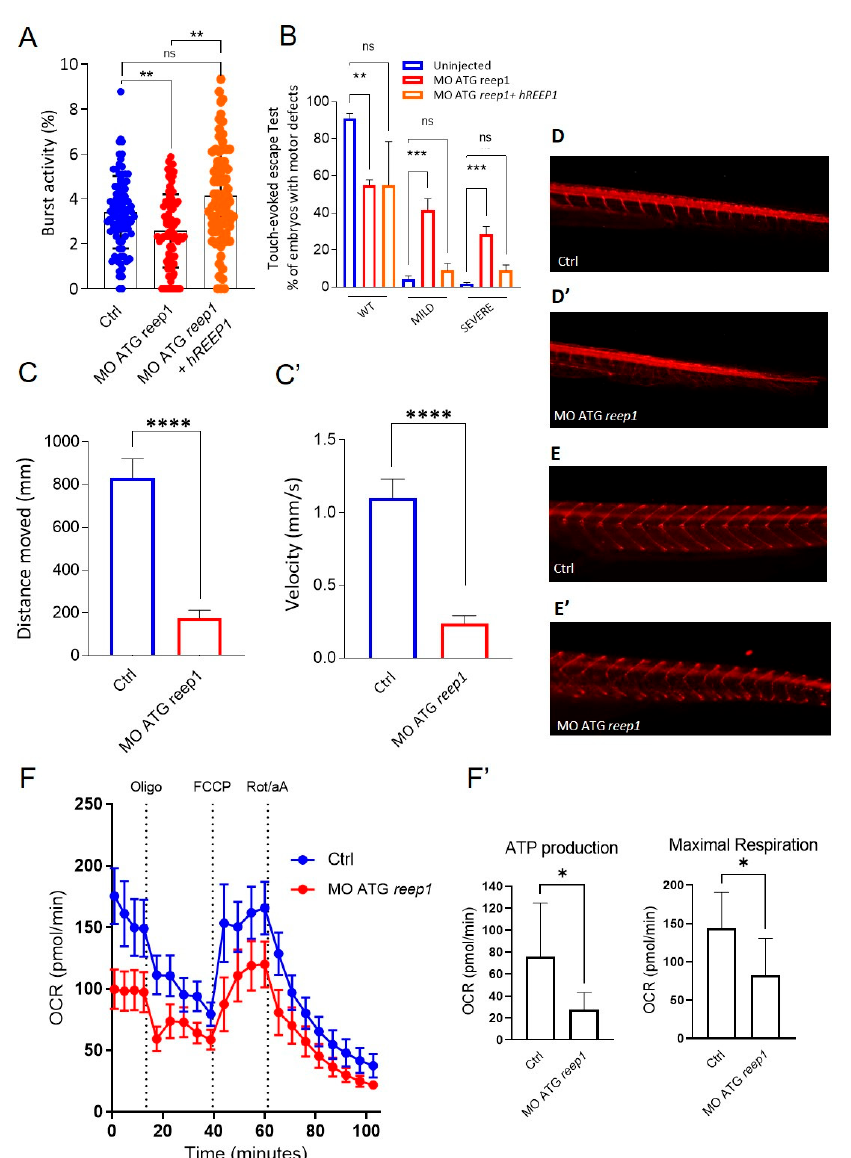
Figure 5. Phenotype characterization of the reep1 zebrafish model. ( A ) Coiling frequency in zebrafish embryos at 30 hpf is decreased in reep1 morphant compared with WT (MO ATG reep1 n = 90; controls n = 90; MO ATG reep1 + h REEP1 n = 90, in 3 independent experiments). The co-injection of embryos at one-cell stage with human mRNA/REEP1 and reep1 MO ATG was able to rescue the locomotor impairment. ( B ) Touched evoked response analysis, showing decreased movement in response to touch stimulus of morphants at 48 hpf compared to uninjected controls. The co-injection of embryos at 48 hpf with human mRNA/ REEP1 and reep1 MO ATG was able to rescue the touched evoked phenotype. Statistics were calculated by a two-tailed unpaired t -test. ( C , C’ ). Automated analysis of spontaneous motor activity revealed a reduction in swim distance and velocity in reep1 morphant larvae at 120 hpf compared to control siblings (MO ATG reep1 n = 120; controls n = 120, in 3 independent experiments). ( D , D’ ). Lateral tail views at 48 hpf of whole-mount larvae labeled with anti-acetylated alfa-tubulin (MO ATG reep1 n = 40; controls n = 40). ( E , E’ ) Lateral tail views at 120 hpf of whole-mount larvae labeled with anti-znp1 (MO ATG reep1 n = 40; controls n = 40). ( F , F’ ) Mitochondrial respiratory analysis of controls ( n = 20) and reep1 morphant larvae ( n = 20) at 120 hpf. Statistics were calculated by Mann–Whitney test in panels ( A , C , F ), whereas in panel ( B ) by two-tailed unpaired t -test. * p < 0.05, ** p < 0.01, *** p < 0.001; **** p < 0.0001, ns, not